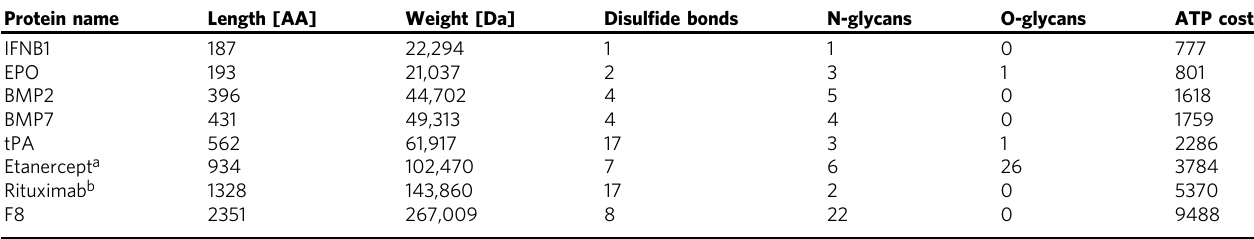
Table 1 Protein-speci fi c information matrix of biotherapeutics secreted in eight iCHO2048s models. Protein name